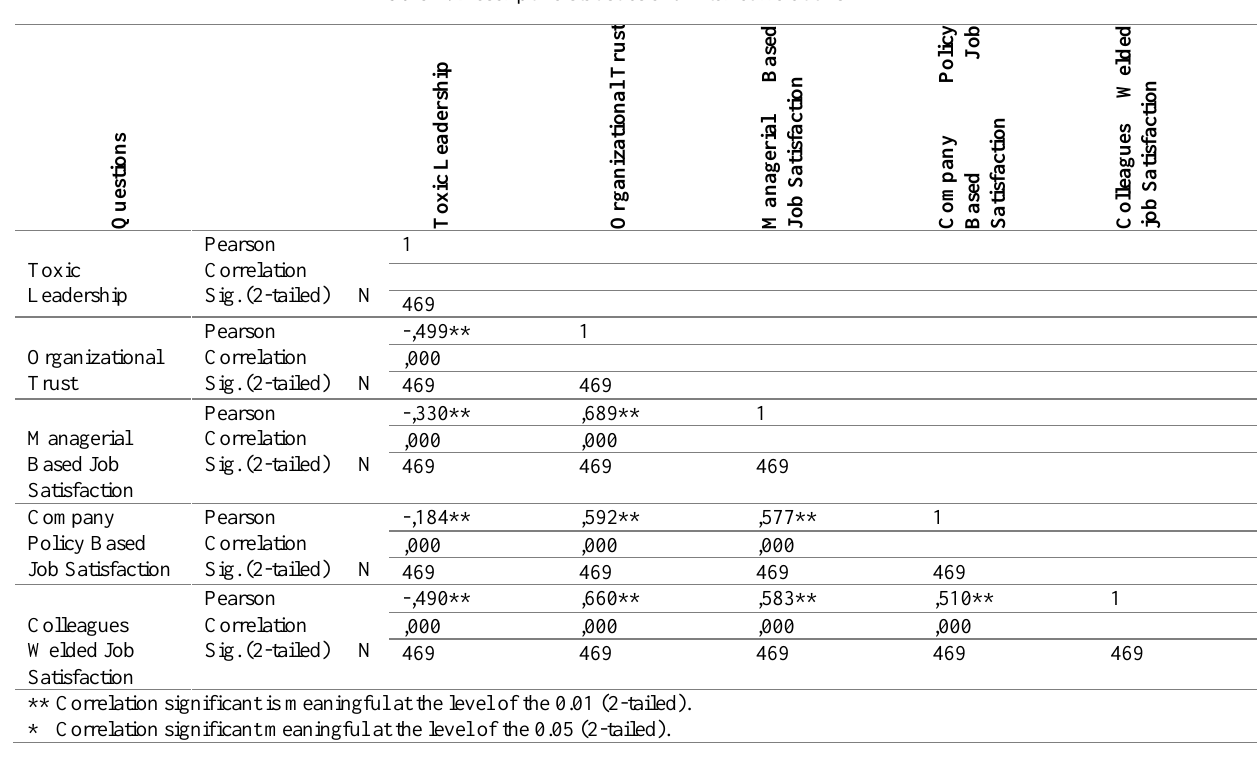
Table 4: Descriptive statistics and